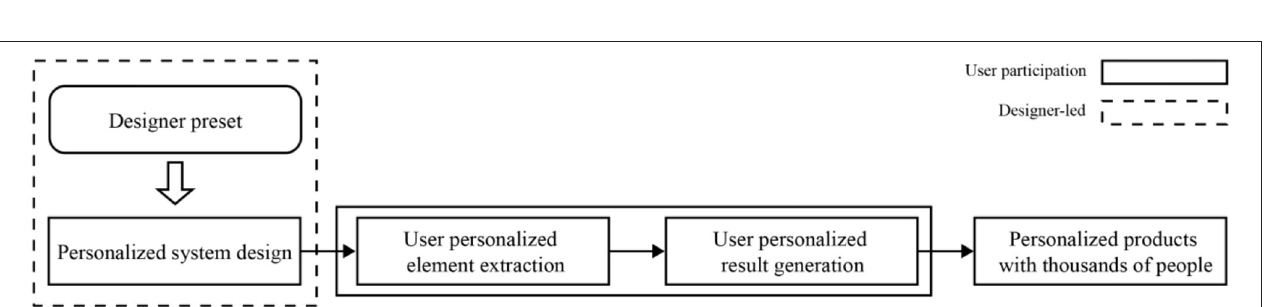
FIGURE 12 | Combining new technology to complete the design of the personalized system.